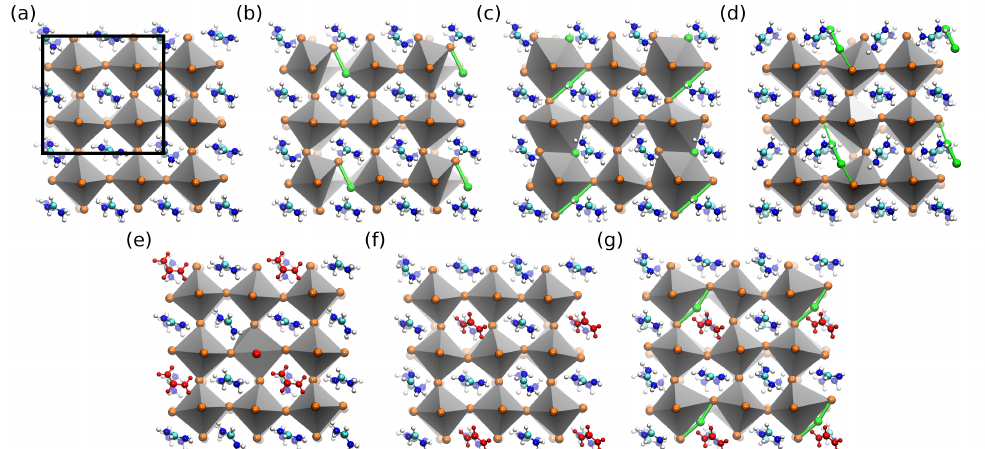
Figure 1. Polymorphic defect structures of FAPbI 3 . A black box in panel ( a ) illustrates the 2 × 2 × 2 supercell used in all calculations. In each case, a 4 × 4 grid of FA molecules and 3 × 3 grid of polyhedra is shown. ( a ) Pristine FAPbI 3 , ( b ) iodine dimer (I − ), ( c ) iodine trimer (I − ), ( d ) iodine 2 3 tetramer (I 2 − ), ( e ) Schottky defect (V − + V + ), ( f ) formamidinium vacancy (V FA ), ( g ) iodine trimer in FA I 4 formamidinium vacancy (V FA + I − ). Polyhedra indicate the lead iodide lattice. Red atoms illustrate 3 the location of FA or I prior to removal in order to form vacancies. Green atoms were added to form defects. Iodine–iodine covalent bonds are shown as green bars. Depth cueing indicates the foreground and background